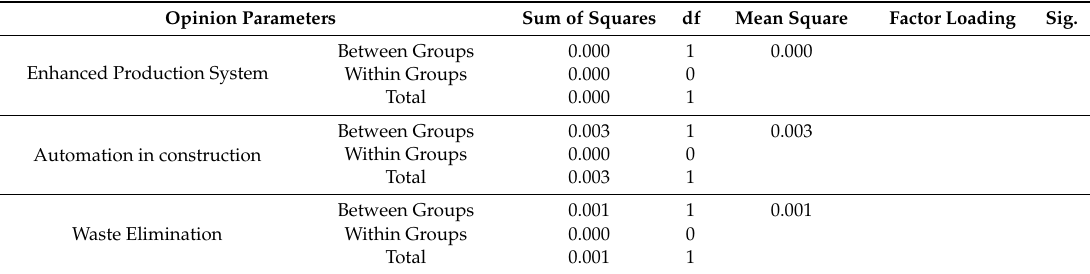
Table 12. Analysis of Variance (ANOVA)